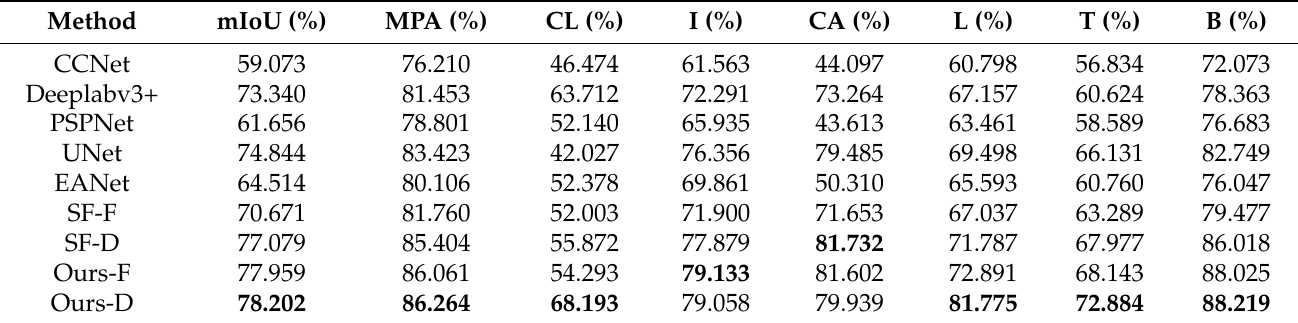
Table 7. Results of other models on Potsdam dataset. CL means clutter. I means impervious surface. CA means car. L means low vegetation. T means tree. B means building. The highest scores are marked in bold.